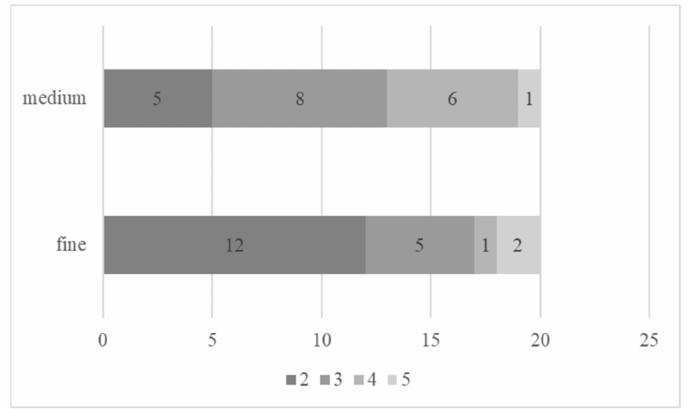
Figure 6. A number of sticks prepared with either fine-grit or medium-grit blades showing various external edge defects. Each color represents different defect scores from 2 to